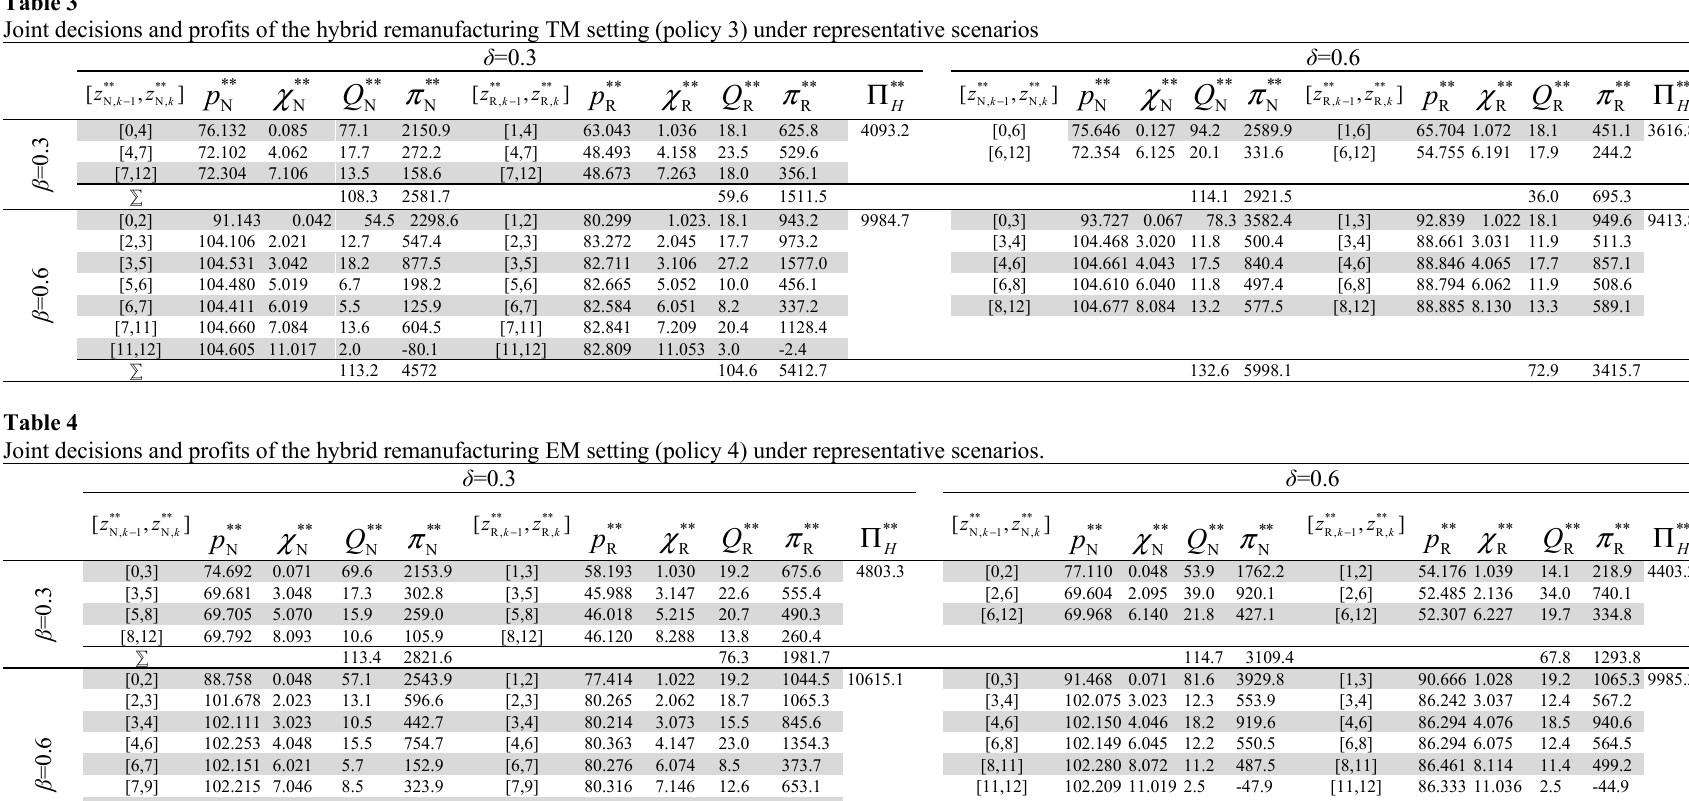
Joint decisions and profits of the hybrid remanufacturing TM setting (policy 3) under representative scenarios δ =0.3